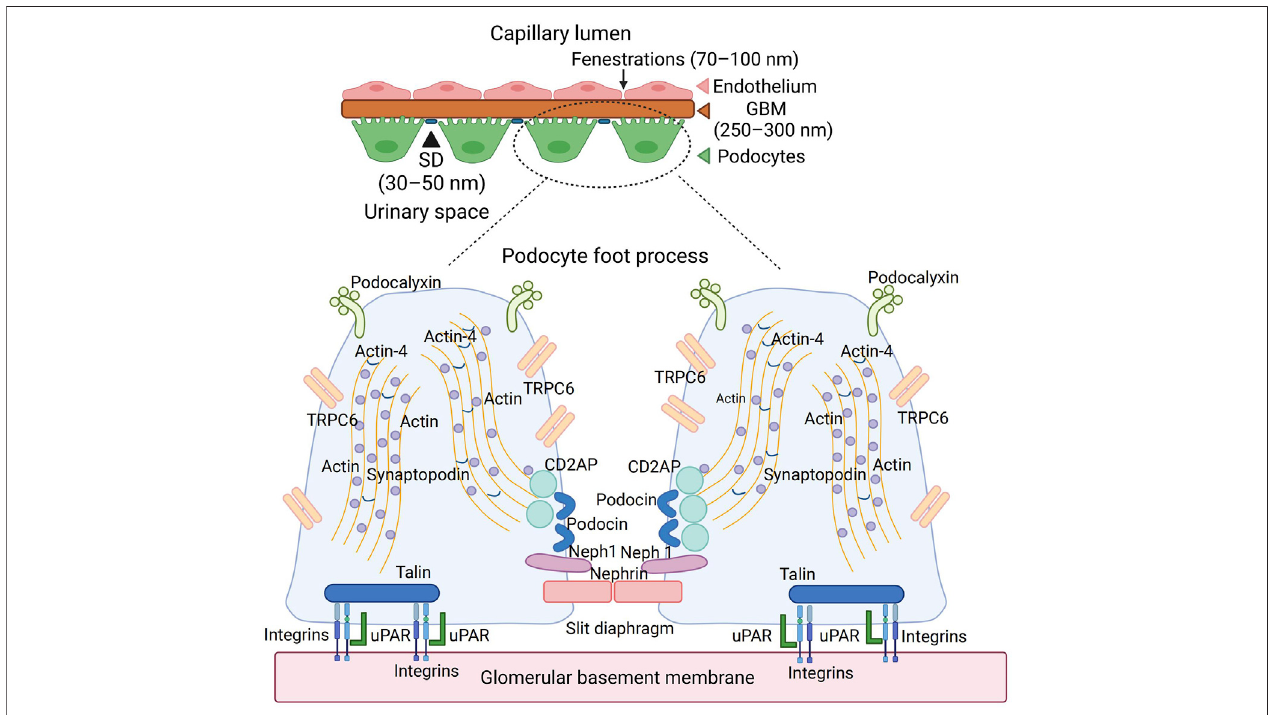
FIGURE1| Theanatomyofglomerularbasementmembraneandpodocyte.Podocyteisthelastbarrieroftheglomerulus fi ltrationmembrane,whichcontainsaslit diaphragm with 30 – 50 nm width. The abundant cytoskeleton proteins, such as actin and synaptopodin, maintain the normal shape of podocytes. The membrane proteins, such aspodocalyxin, TRPC6, podocin, and nephrin,played an essential role inthe podocyte function. Podocyte anchored into theGBM through integrins and uPAR interaction. TRPC6, transient receptor potential cation channel subfamily C member 6; GBM, glomerular basement membrane; uPAR, urokinase-type plasminogen activator receptor; CD2AP, CD2-associated